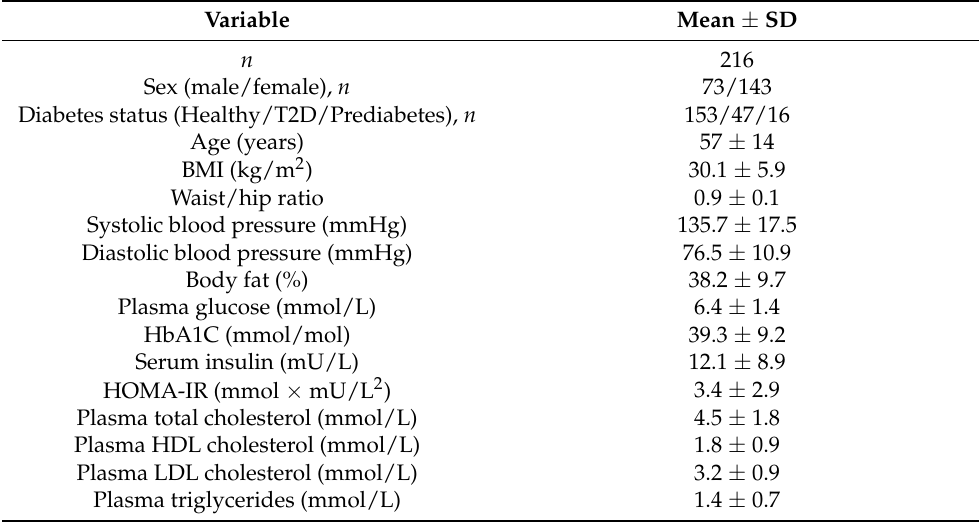
Table 7. Biochemical and anthropometric characteristics of the